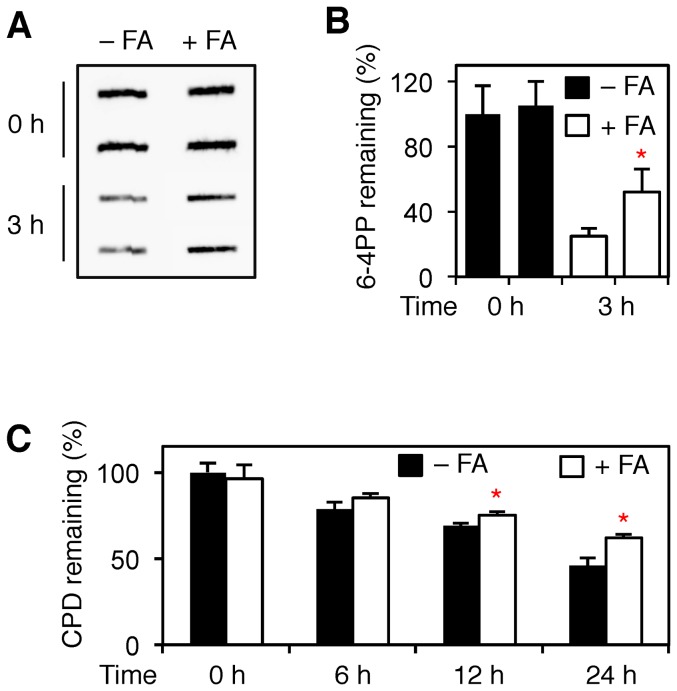
Inhibition of UV lesion removal from chromatin.(A) Untreated or formaldehyde-treated cells (75 μM, 18 h) were exposed to UV light (10 J/m2) and collected immediately after irradiation or following 3-h repair incubations. Genomic DNA was isolated and analyzed for UV lesions using antibodies against 6-4PPs. (B) Quantification of three independent experiments demonstrating that 6-4PP excision is diminished by 75-μM formaldehyde exposure (error bar, S.D.). The asterisk (*p<0.05) denotes significantly reduced excision in formaldehyde-treated cells compared to the untreated control. (C) Quantification of three independent experiments demonstrating that CPD excision is also inhibited. The asterisks (*p<0.05) denote the significantly reduced excision in 75-μM formaldehyde-treated cells compared to untreated controls.